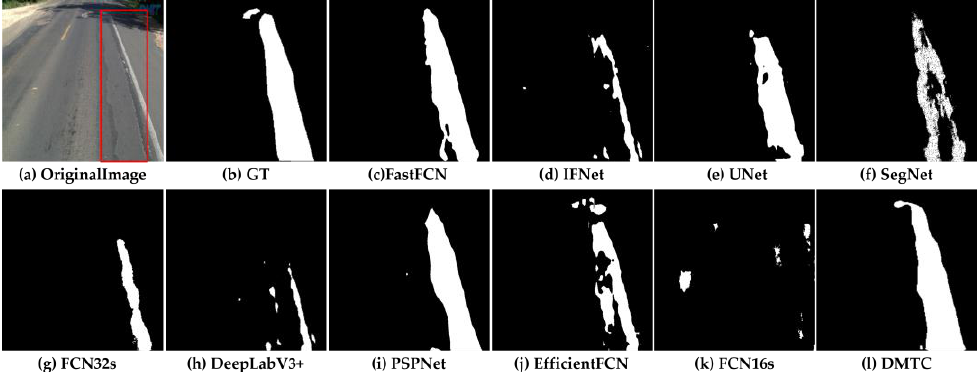
Figure 9. Visual comparison of the results of a series of segmentation methods for large potholes on